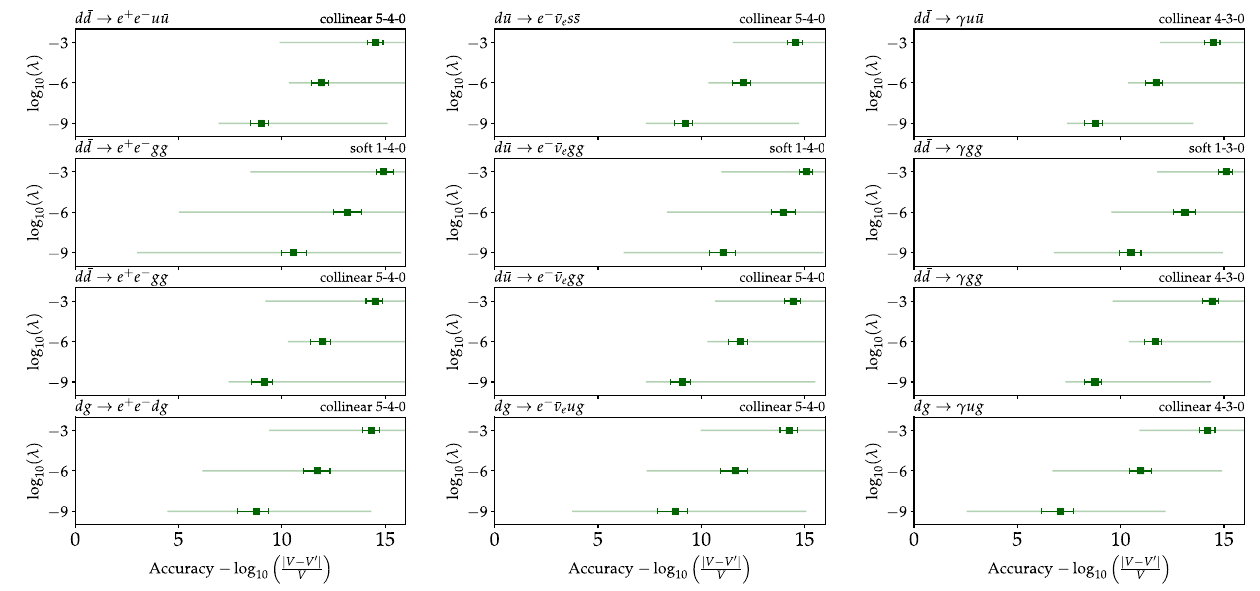
Fig. 4 Test of the numerical accuracy of standard-model four-parton one-loop amplitudes in the soft and collinear limits Fig. 5 Test of the numerical accuracy of HEFT three- and four-parton one-loop amplitudes in the soft and collinear